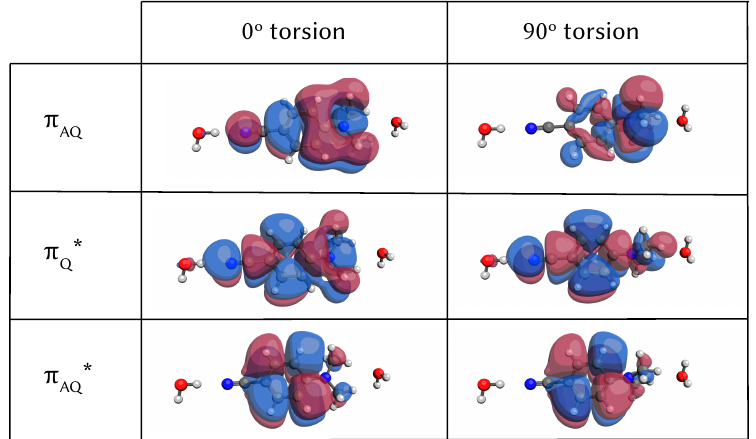
Figure 3. Evolution of the DFT frontier orbitals along the torsion of the NMe2 group extracted from the TDA-wB97X-D3/cc-pVDZ scan that can be found in Figure S3. 0º means optimised GS minimum geometry. The 90º orbitals resemble very closely the ones of the CT minimum (ignoring the pyramidalisation of the carbon next to the NMe2 group) and show clearly that the CT character comes from the hole orbital π AQ , where the electronic density moves towards the methylene group.